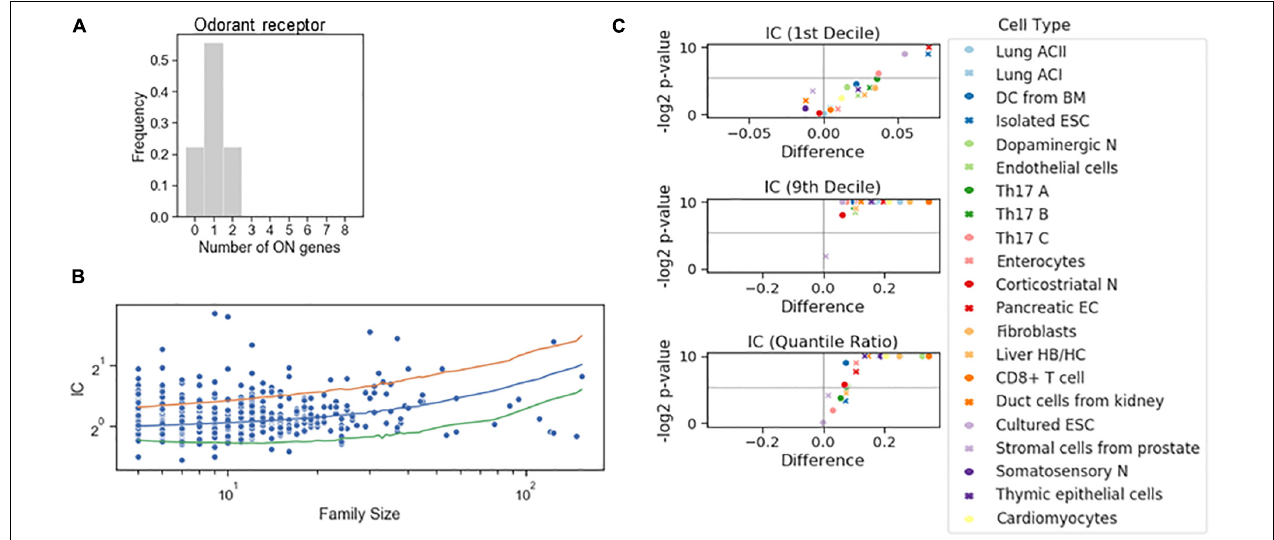
FIGURE 4 | Stochastic interdependence in gene families. (A) The number of expressed genes per cell in the family of odorant receptor genes, dichotomized with the familywise threshold (70.7 TPM). Number of cells is N = 27. (B) IC values of individual families in somatosensory neuron dataset, grouped by the family size. The majority of the families with ICs exceeding either 2.5 or 97.5 IC percentiles of the shuffled genome (orange and green lines, respectively) are concurrent. (C) Volcano plots showing the difference of 1st decile, 9th decile and quantile Ratio IC values between the original and the shuffled genomes, along with the corresponding P -values (permutation test) calculated for the gene families consisting of 7 genes.